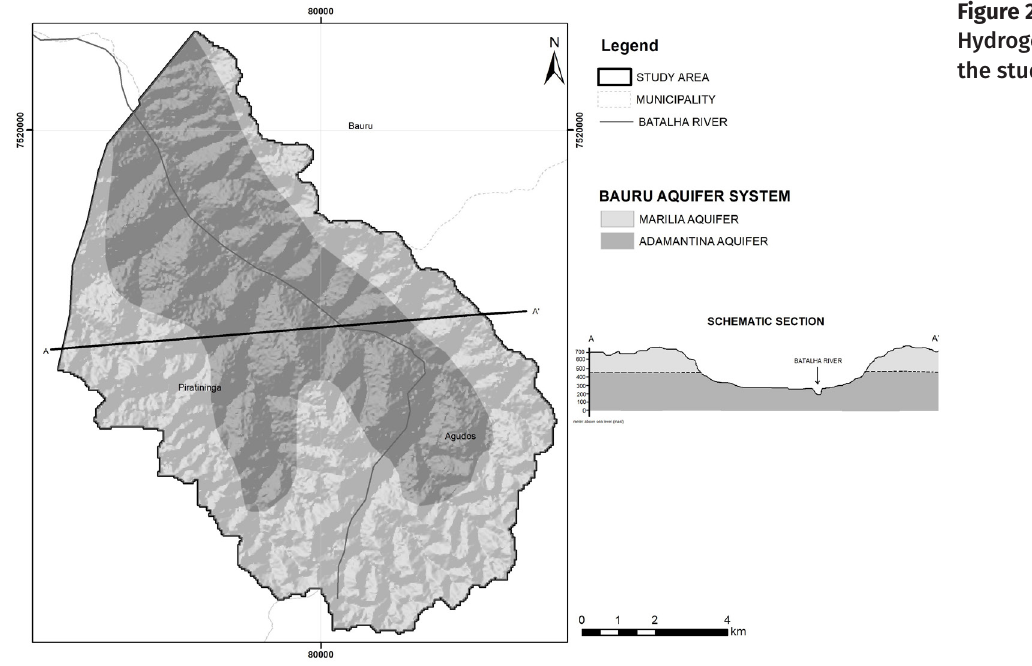
Figure 2. Hydrogeology of the study